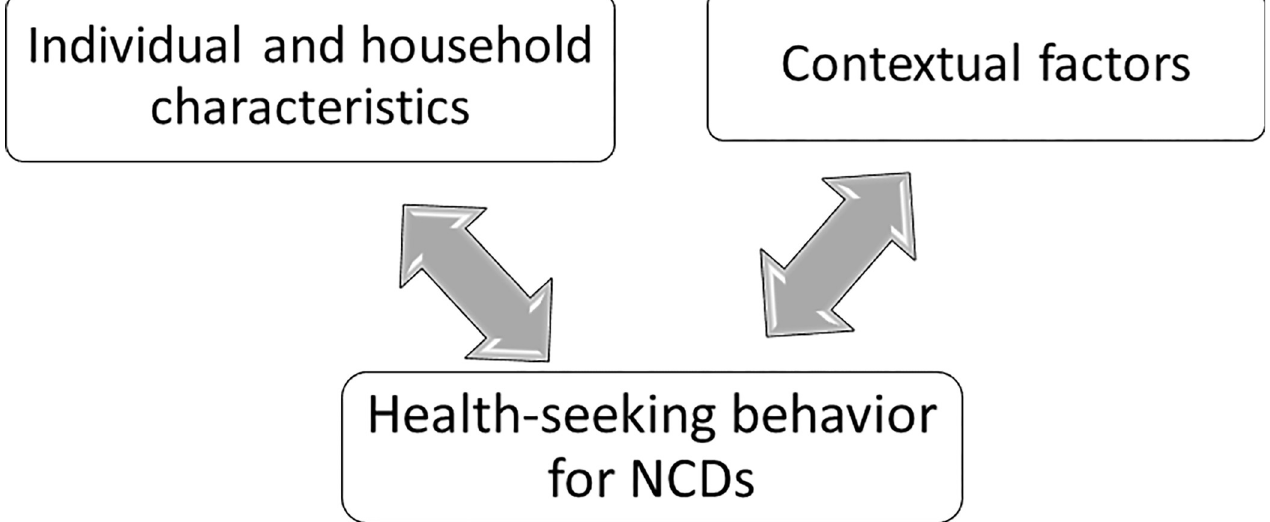
Fig 1. Conceptual framework: Health-seeking behavior for non-communicable diseases (NCDs).